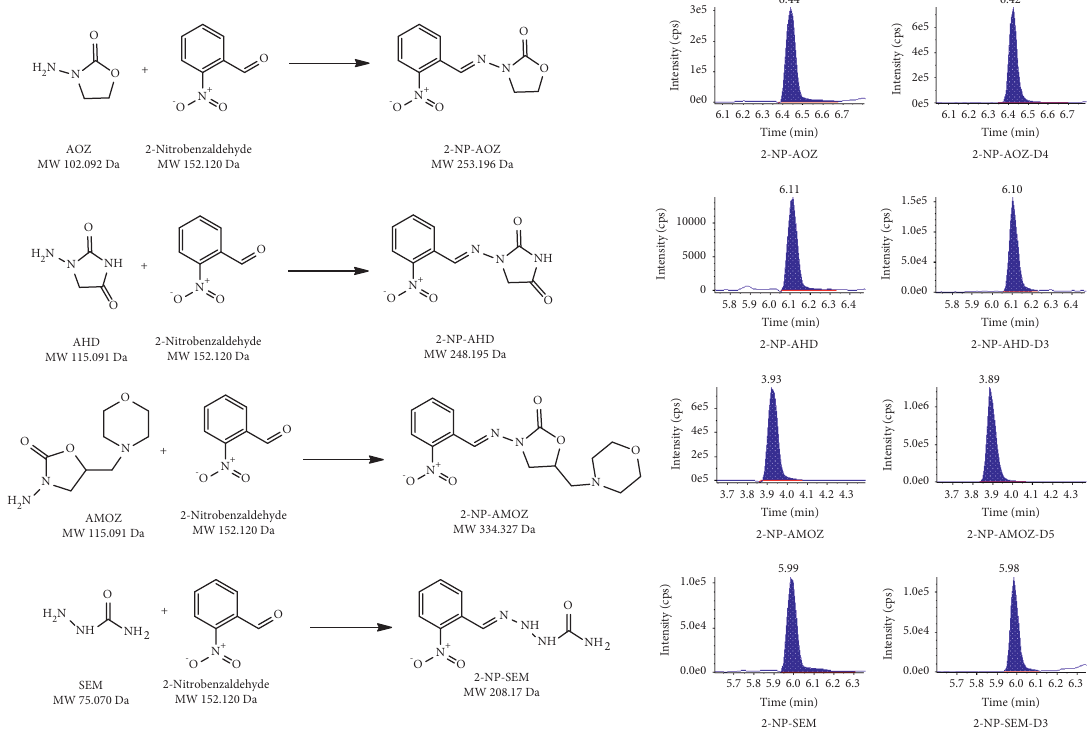
Figure 6: Chromatograms of NFMs (0.5 μ g/kg) and the ISs in the pork Table 4: Results of NFM determination in CNAS proficiency testing samples measured by the GB method and wooden tip method. Analyte Sample no.